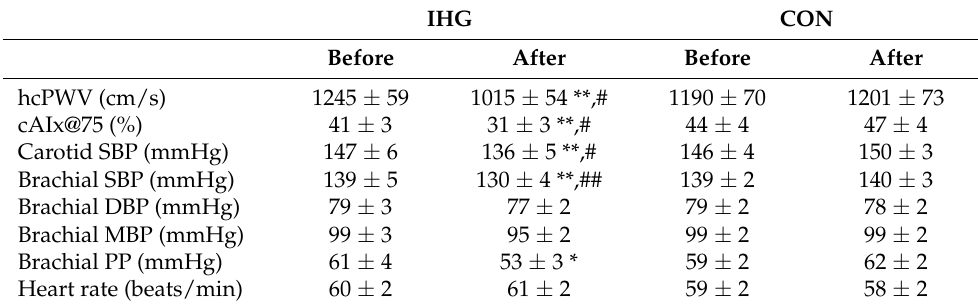
Table 2. Changes in hcPWV, cAIx@75, BP, and heart rate.